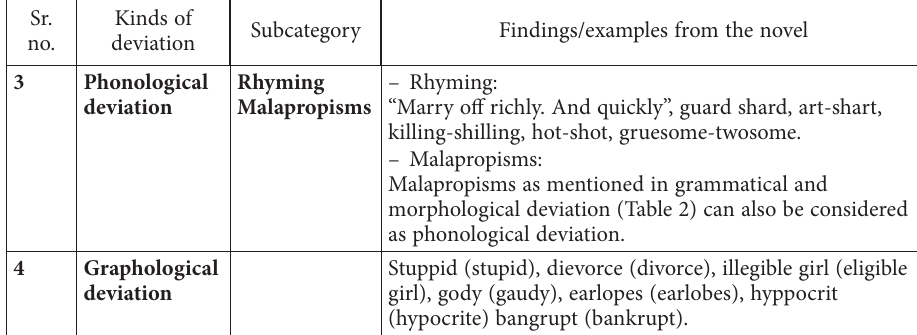
Table 3. Types and examples of phonological and graphological deviation in Moni Mohsin’s Duty Free (a novel) (source: created by author) Sr.